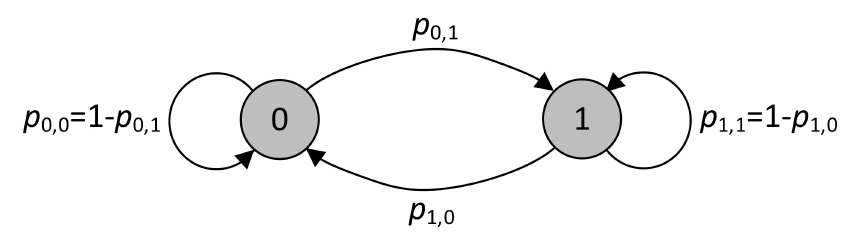
Figure 2. The Markov chain, binary state model